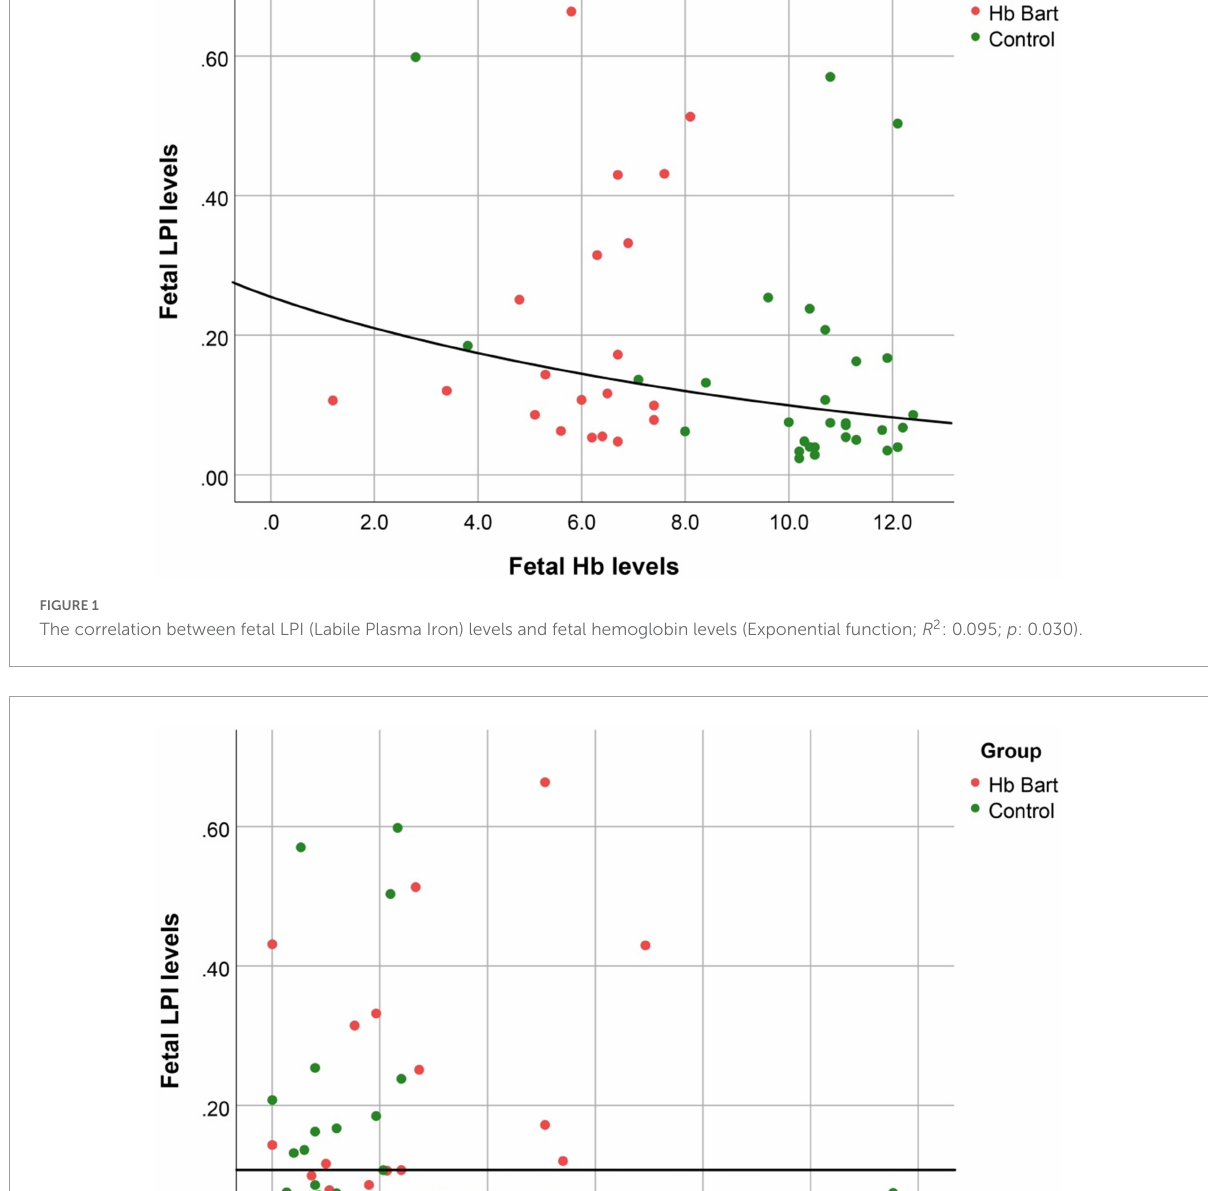
cardiac output; and (6) Other findings are confirmatory to existing knowledge such as cardiomegaly and increased MCA-PSV in fetal anemia,